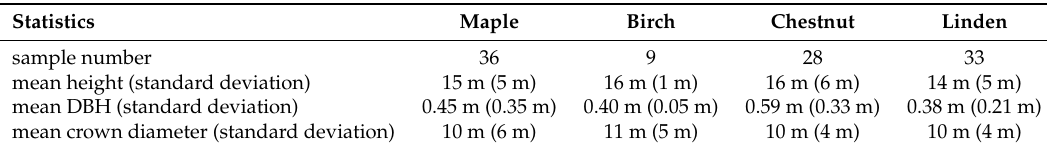
Table 1. Trees inventory ( n =